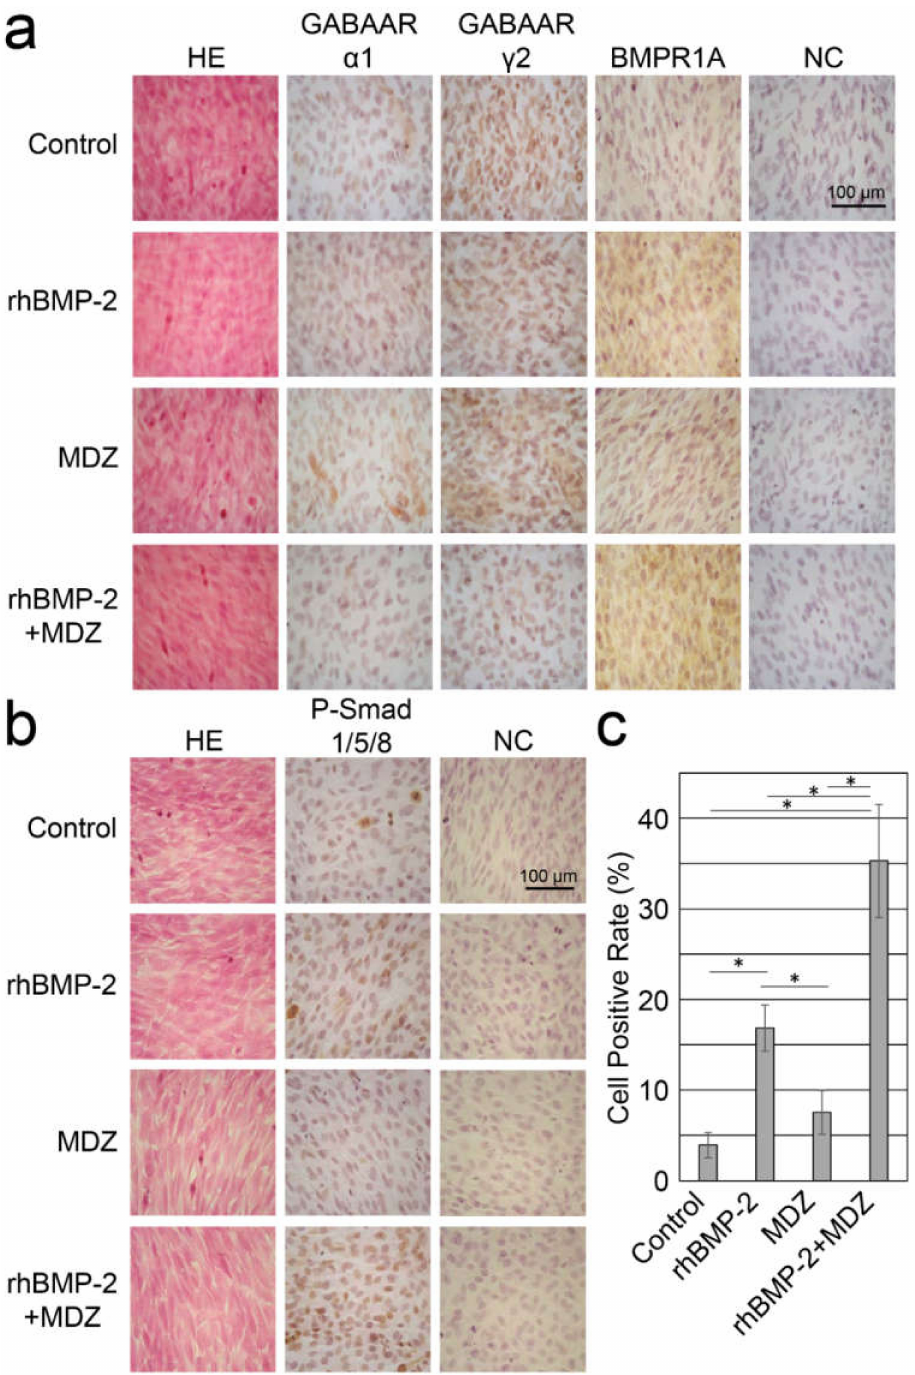
Figure 9. Combined e ff ect of MDZ and BMP-2 on signal transduction in C2C12 cells. ( a , b ) Hematoxylin and eosin (H&E)-stained C2C12 cells detected by transmitted-light microscopy (magnification: 400 × ). The control was processed without a primary antibody (NC). Immunohistochemical detection of ( a ) GABAA receptor α 1 (GABAAR α 1) and γ 2 (GABAAR γ 2) subunits, and BMP receptor type 1A (BMPR1A) in C2C12 cells on day 7 and ( b ) phosphorylated-Smad1 / 5 / 8 (p-Smad1 / 5 / 8) in C2C12 cells on day 1 following culture in the absence (Control) or presence of rhBMP-2, MDZ, and rhBMP-2 + MDZ. ( c ) Cell positive rate for p-Smad1 / 5 / 8 antibody ( n = 5). Values are the mean percentage ± standard error (* p < 0.01, Mann-Whitney U